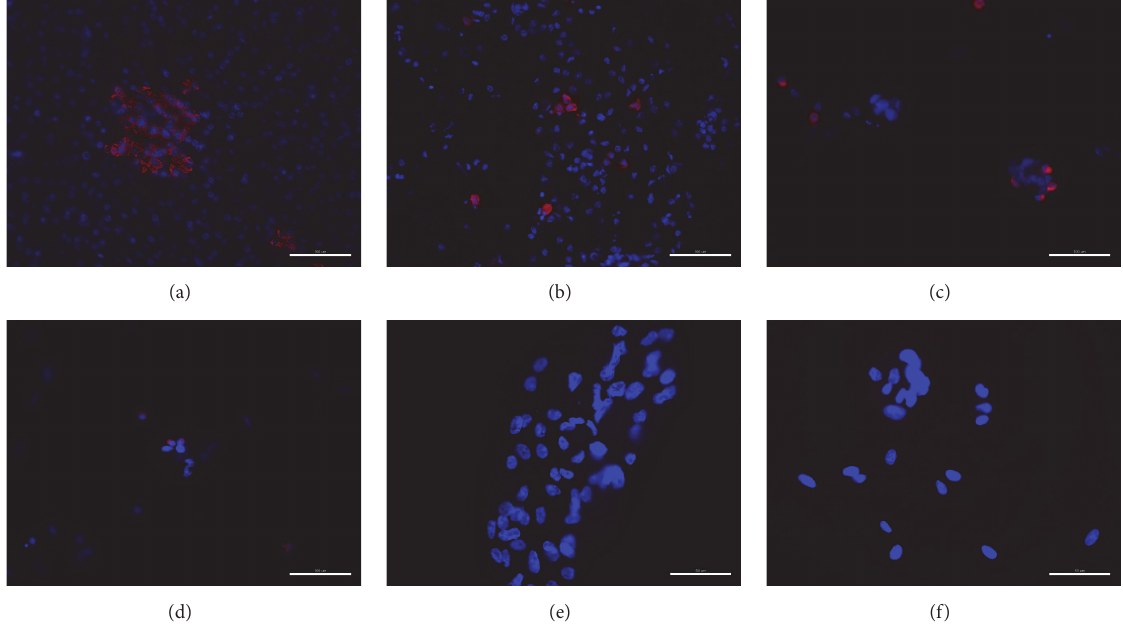
Figure 2: Insulin expression in islet-derived cells in culture. The immunostaining images were obtained from intact pancreatic islet tissue (a), islet-derived cells immediately after islet digestion (b), and after 3 days (c) and 6 (d) days in culture, at 8 days after P1 (e) and at 4 days after P2. Colors show insulin (red) and DAPI (blue) staining. Scale bars = 100 𝜇 m (a–d) and 50 𝜇 m (e,